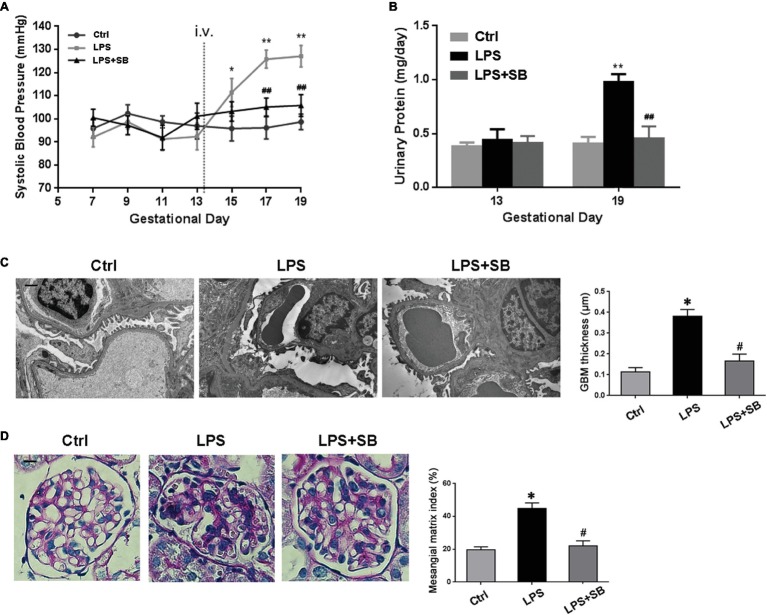
Effects of p38 inhibition on the hypertension and proteinuria of LPS induced PE-like rats and the morphological features of their kidneys. (A,B) The SBP and urinary protein were presented, respectively. No remarkable alterations in SBP and 24 h urinary protein levels were observed before LPS infusion among different groups. After injection, SBP levels of LPS-treated rats were much higher and were prohibited and restored by SB203580 from GD 17. The 24 h urinary albumin excretion was significantly higher in LPS-treated group after LPS infusion, and these abnormalities were essentially prevented by treatment of SB203580. Values denote the mean ± s.d.; p > 0.05 vs. control before LPS infusion, *p < 0.05, **p < 0.01 vs. control on the corresponding GD after LPS infusion. ##p < 0.01 vs. LPS-treated group on the corresponding GD after LPS infusion. (C) Kidney ultrastructure on TEM in different groups. GBM thickening and foot process effacement were demonstrated in LPS group, which were attenuated in LPS-p38 inhibitor group. Scale bar = 1 μm. (D) Mesangial and glomerular area by PAS staining. There occurred moderate mesangial proliferation, GBM thickening, and adhesion of the glomerular tuft to the Bowman’s capsule in LPS-treated group, indicative of advanced renal injury. These mutations were attenuated in LPS-p38 inhibitor group. Values denote the mean ± s.d.; *p < 0.01 vs. control, #p < 0.01 vs. LPS-treated group. Scale bar = 100 μm. Ctrl, control group; SB, SB203580.